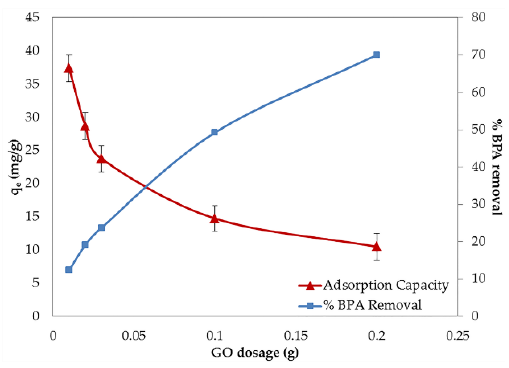
Figure 3. Effect of the GO dosage on the adsorption of BPA. q e : the amounts of BPA adsorbed on GO at equilibrium (mg/g).